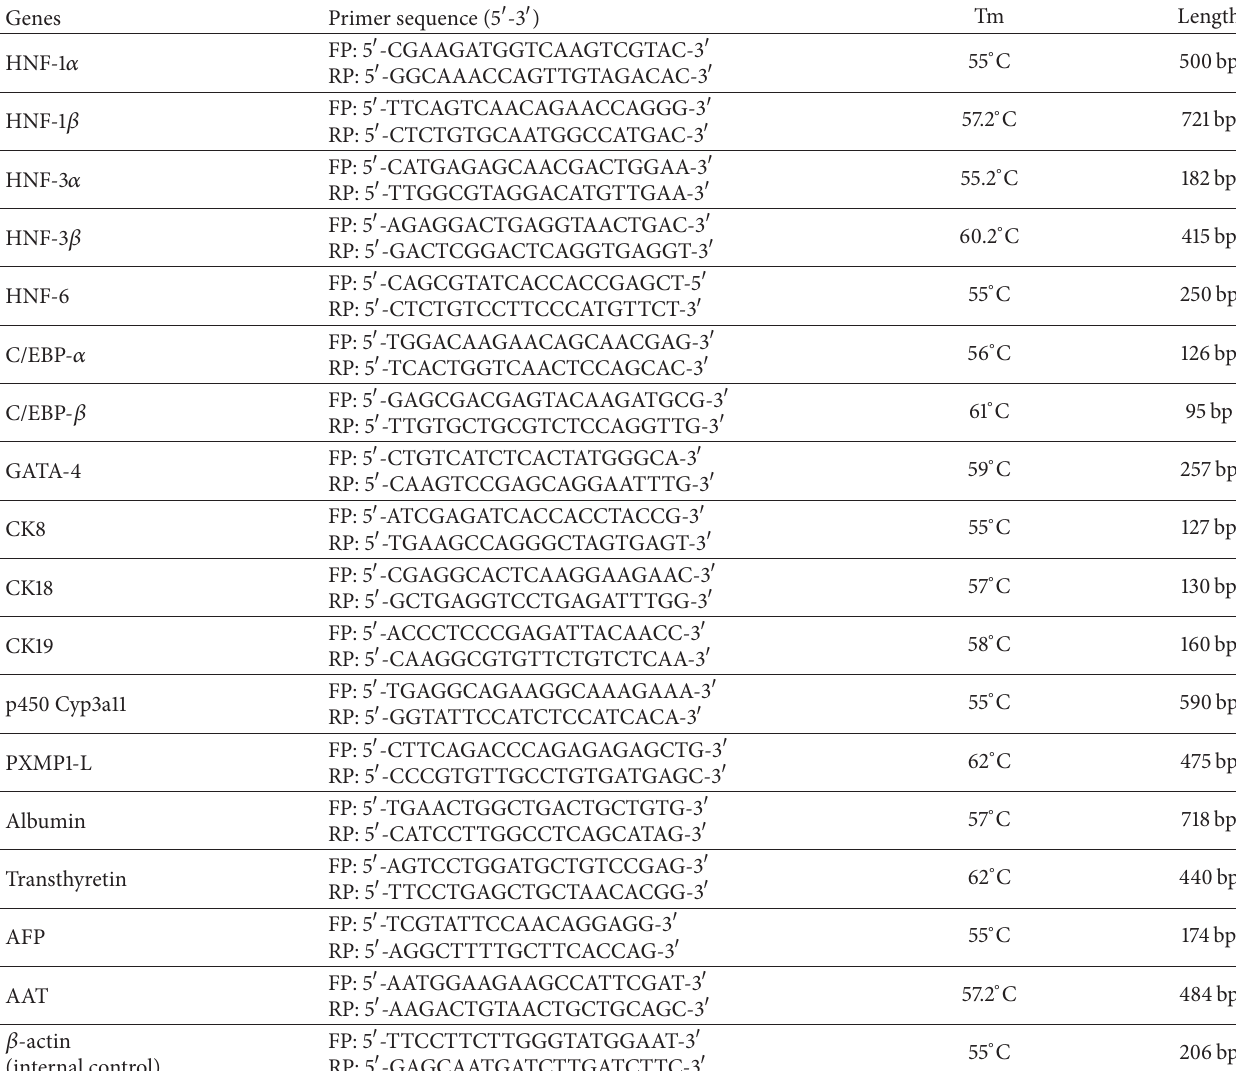
Table 1: List of primers used in gene expression